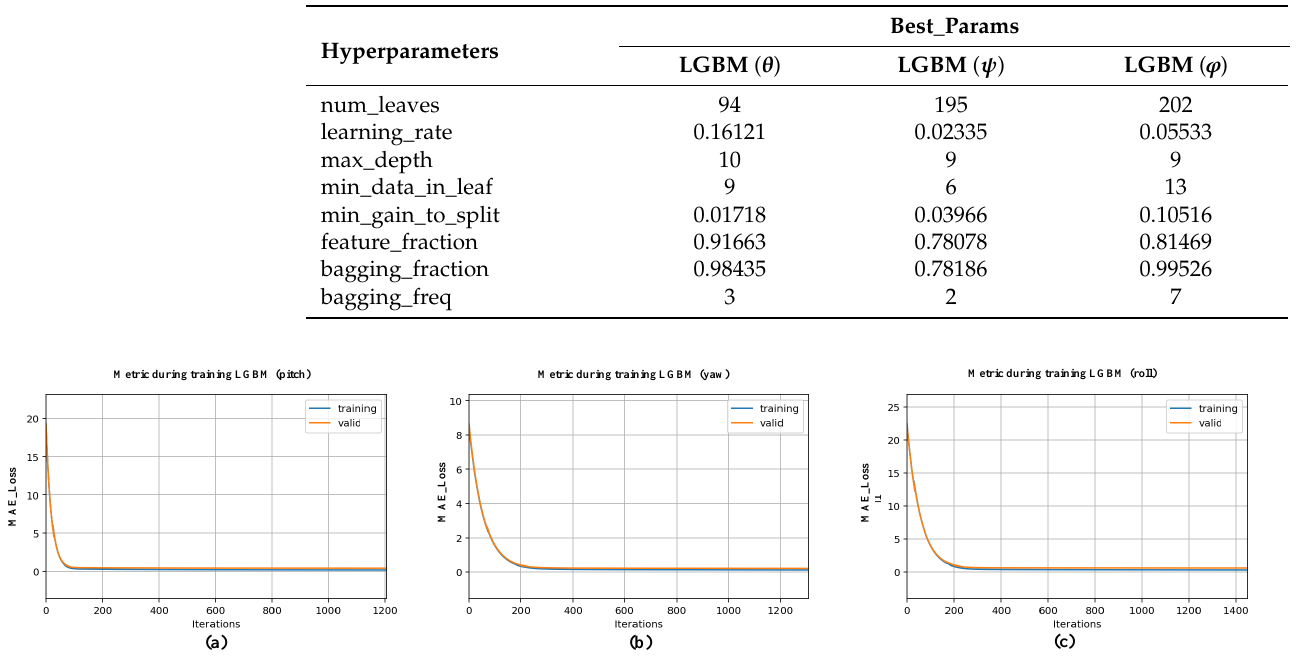
Table 1. Bayesian hyperparameters optimization results for dual-view images.